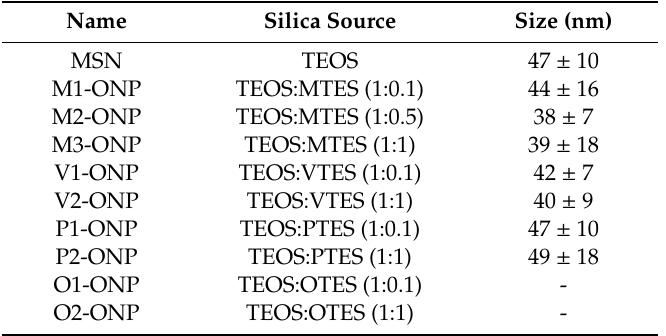
Table 1. Silica nanoparticles synthesized and their average size by TEM.